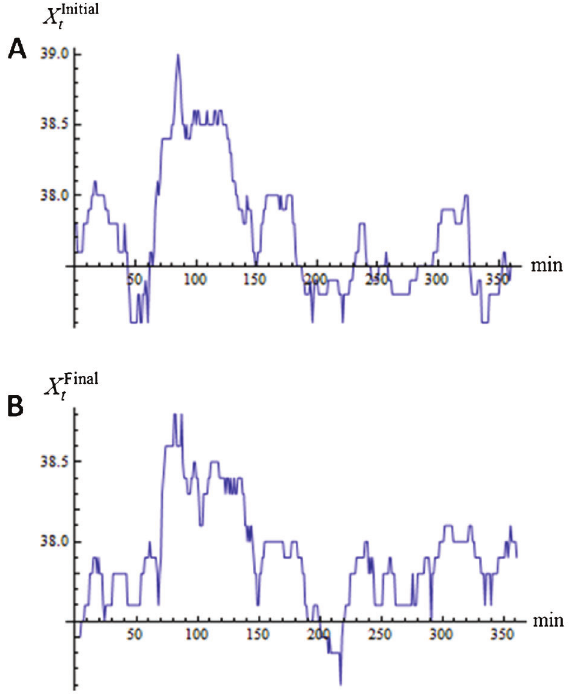
for the standard diet ( panel Figure 2. Temperature series X SD t A ) compared to X HFD for the high-fat diet ( panel B ). t